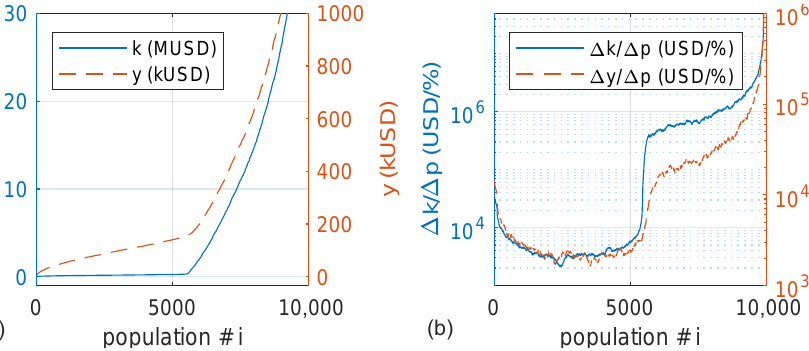
Figure 4. Tax rate t = 0%. From left to right: ( a ) Distribution of capital and income in a 1 × 10 5 population after 73 years with Keynesian tax policy. ( b ) Differentiation of the wealth with respect to wealth percentile smoothed with a mean window of size